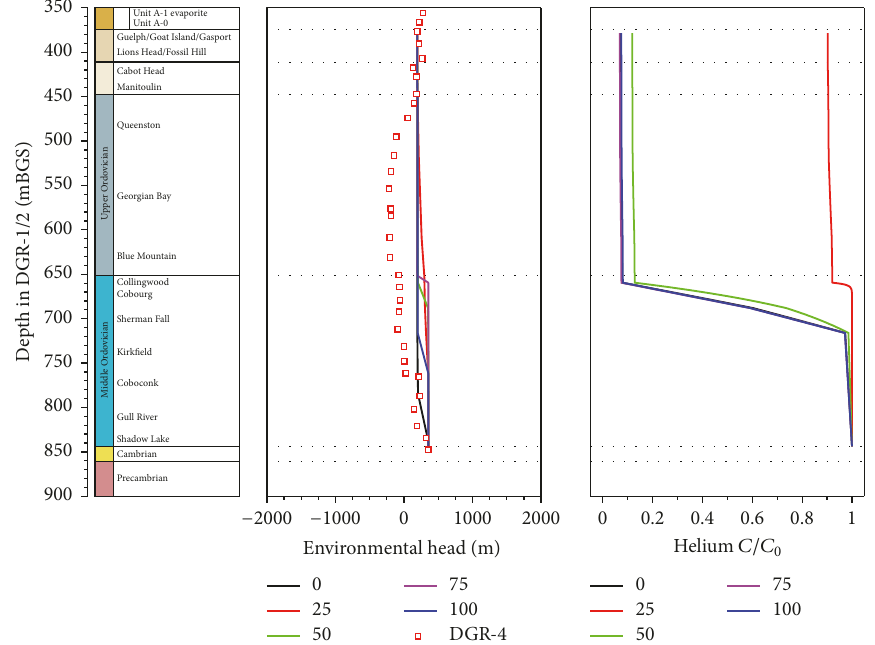
Figure 13: Simulation of helium unit tracer over 260 Ma using calibrated vertical hydraulic conductivities for glaciation scenario nn9930 for calibrations using a hydrostatic head condition computed assuming steady-state. Coloured lines represent different percentages of ice-sheet thickness applied as excess head to the top boundary